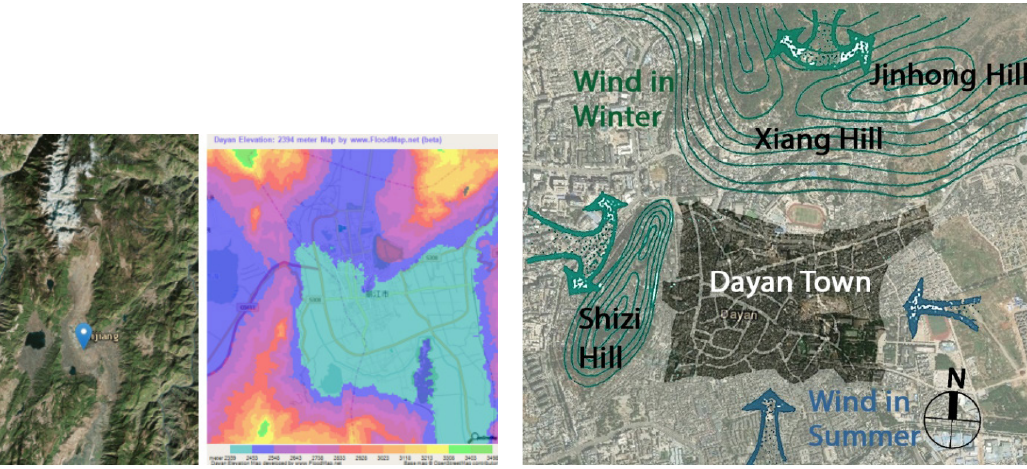
Figure 5. The topography surrounding Lijiang where the Naxi mainly lived (left: satellite image from OpenStreetMap; middle: from FloodMap and OpenStreetMap; right: by the first